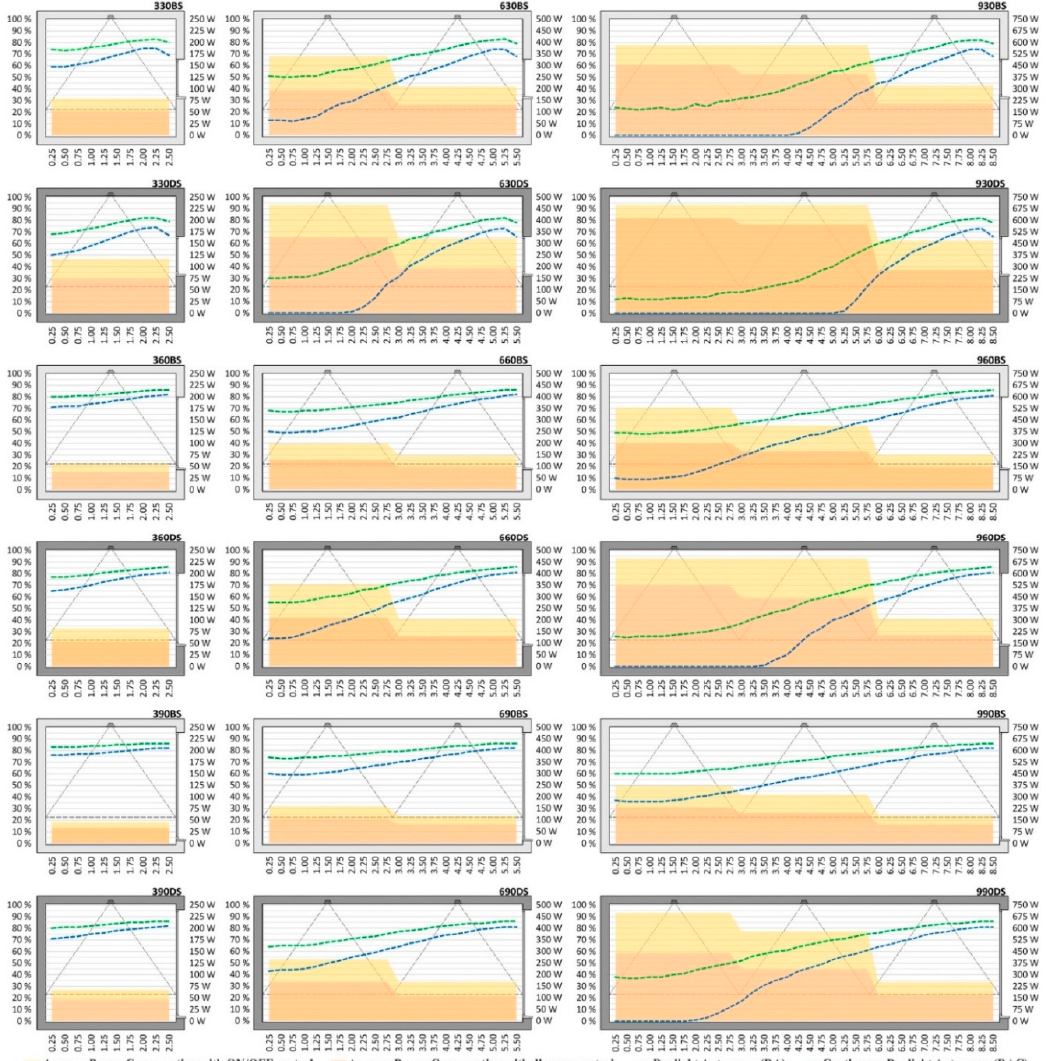
Figure 4. Dynamic daylight metrics and average power consumption according to different smart controls for room models located in Stockholm. Table 6. Average power consumption in W/m 2 of different lighting smart controls in Stockholm.